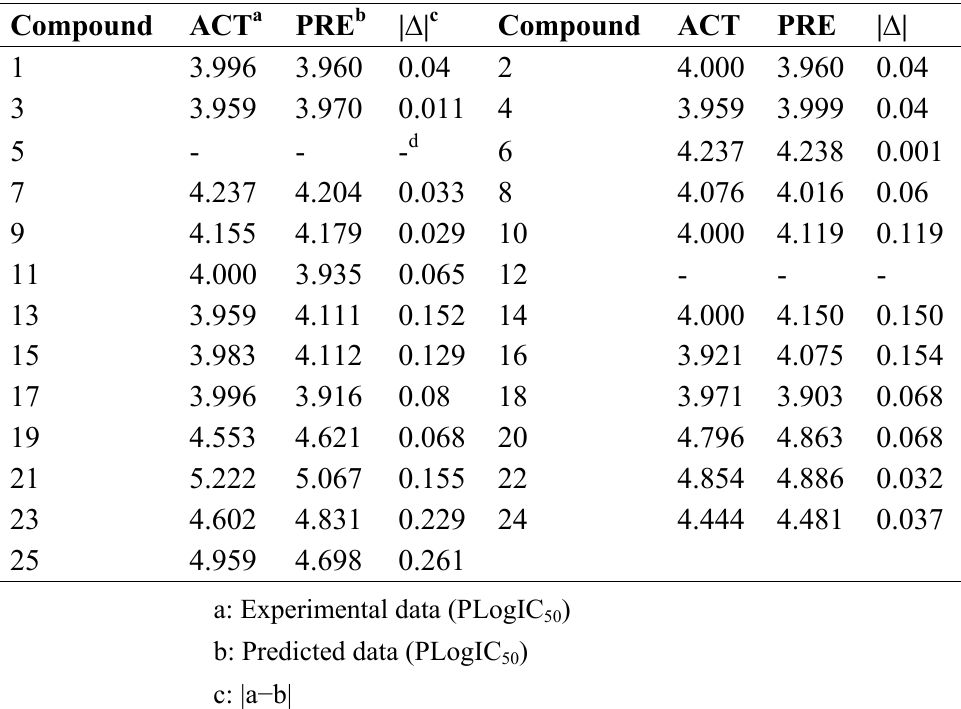
Table 4. Comparison between predicted PLogIC50 of database and experimental values by using Model 16